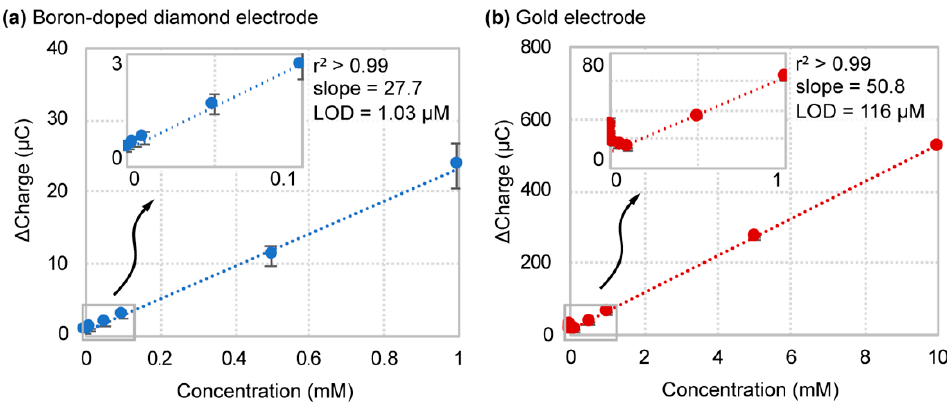
Figure 3. Hexacyanoferrate (II/III) titration and linear regression curves for ( a ) boron-doped diamond and ( b ) gold electrodes in 1× PBS.